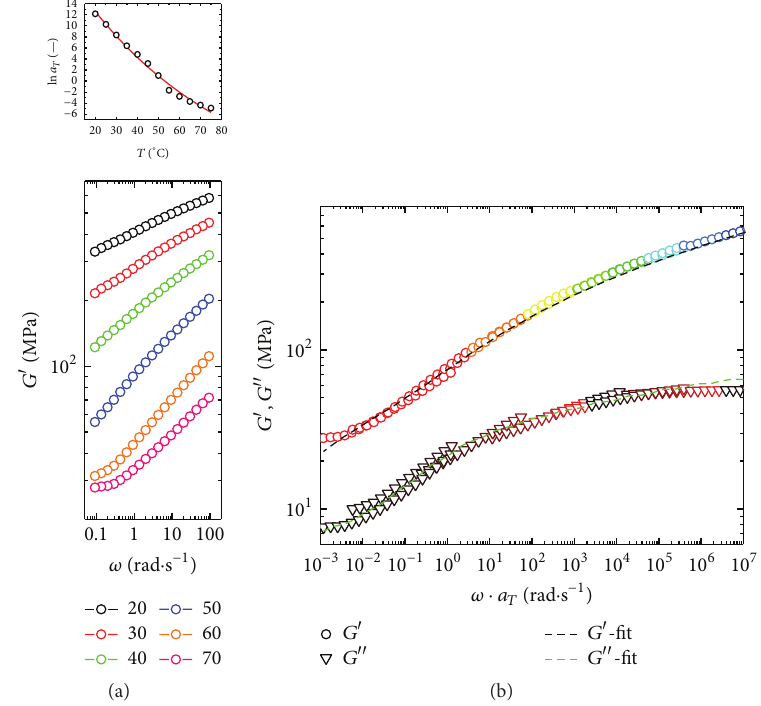
Figure 7: (a) Storage modulus as a function of angular frequency at different isothermal conditions obtained from DMTA experiments and (b) master curves of storage and loss moduli shifted to a reference temperature of 𝑇 𝑟 = 50 ∘ C. The solid line in the insert shows the calculated shift factors obtained from WLF